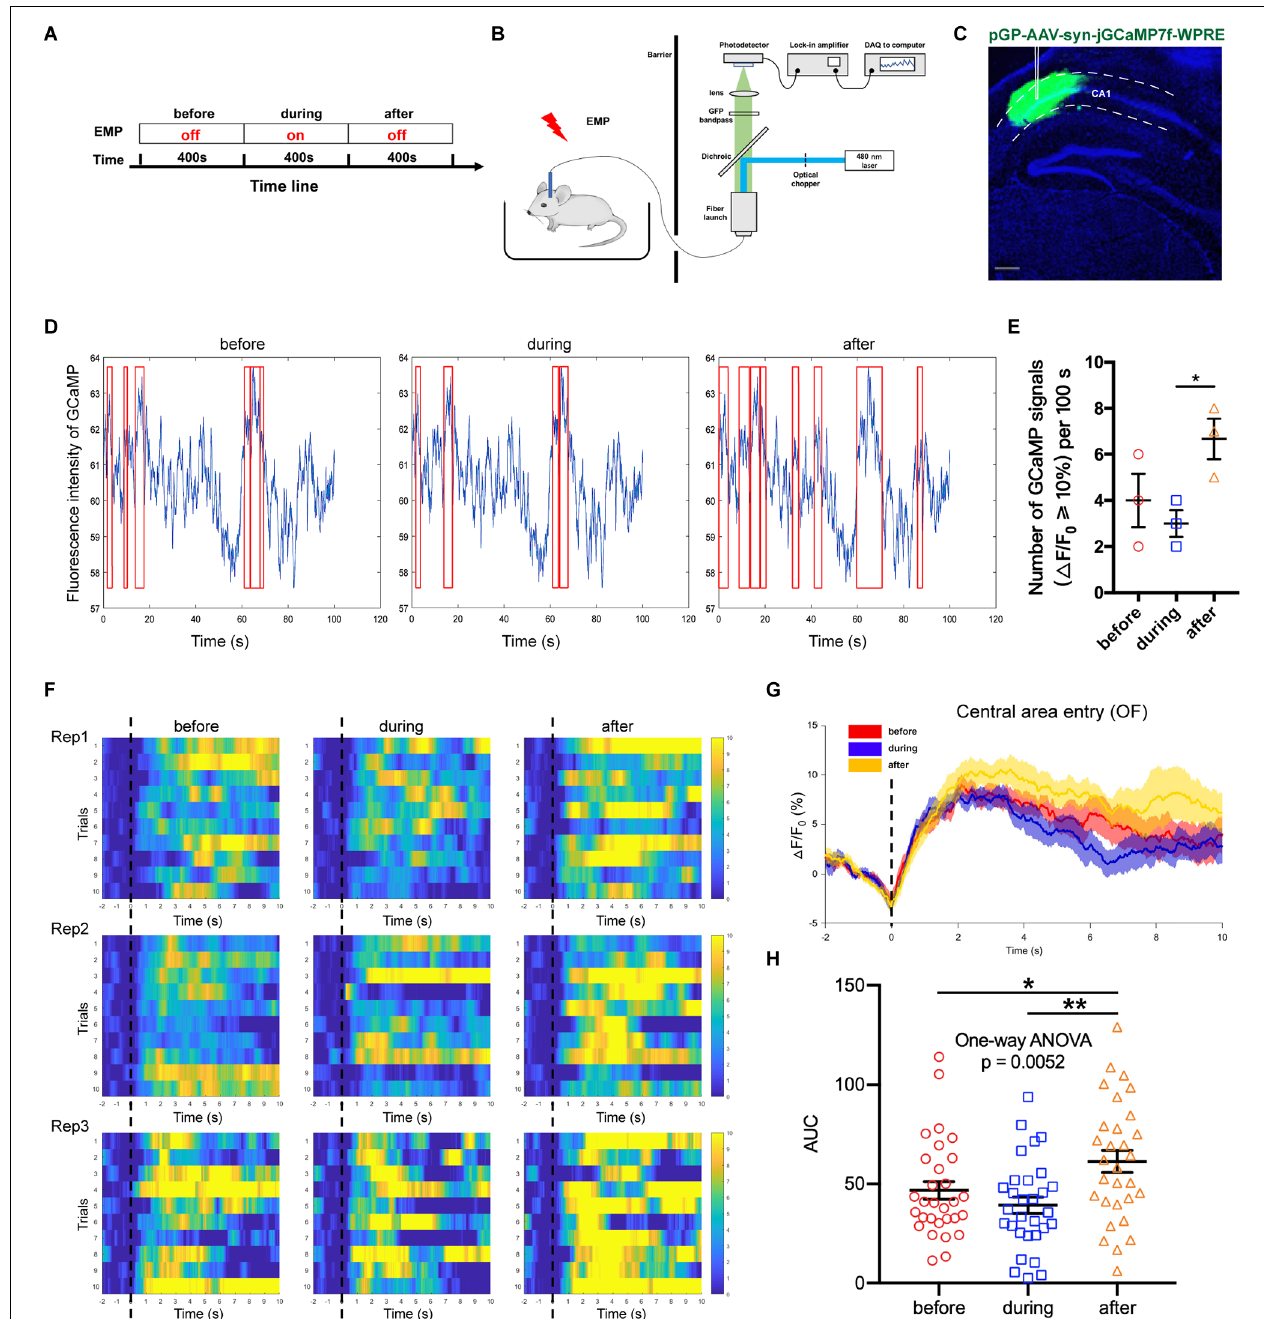
FIGURE 5 | EMP real-time exposure disturbed neuronal activities in hippocampus CA1 ( n = 3 mice). (A) Timeline of the experiment, “before” indicates 400 s prior to EMP exposure, “during” indicates 400 s during real-time EMP exposure, “after” indicates 400 s after EMP radiation end. (B) Schematic of the experimental setup for fiber photometry of neuronal GCaMP fluorescence from freely behaving mice in an open field (OF) receiving EMP exposure. (C) Representative photos of GCaMP in situ , showing that the virus AAV-syn-jGCaMP7f-WPRE was well expressed in the CA1 area of dorsal hippocampus, with accurate localization and no diffusion. (D) Representative images of the measured fluorescence intensity of GCaMP in hippocampal CA1 before, during and after EMP exposure. Red box indicates the neuronal calcium signals with amplitude ≥ 10% (offset = 20). (E) Statistical analysis of the number of GCaMP signals with (cid:52) F/F 0 ≥ 10% per 100 s before, during and after EMP exposure, as presented in (D) , from three biological replicates. (F) Heat map of calcium amplitude (cid:52) F/F 0 (%) of hippocampal CA1 neurons from three biological replicates before, during and after EMP exposure. (G) Plot of average calcium amplitude (cid:52) F/F 0 (%) of three biological replicates before, during and after EMP exposure. (H) Plot of area under the curve (AUC) of neuronal calcium signals from multiple trials on three biological replicates before, during, and after EMP exposure. 0 s for (cid:52) F/F 0 , marked by dotted lines, indicated that mice were entering the central area of OF. The data in (E–H) are presented as mean ± SEM. One-way ANOVA followed by Bonferroni’s post-hoc tests were used to compare the differences between multiple groups in (E–H) . * p < 0.05; ** p < 0.01.